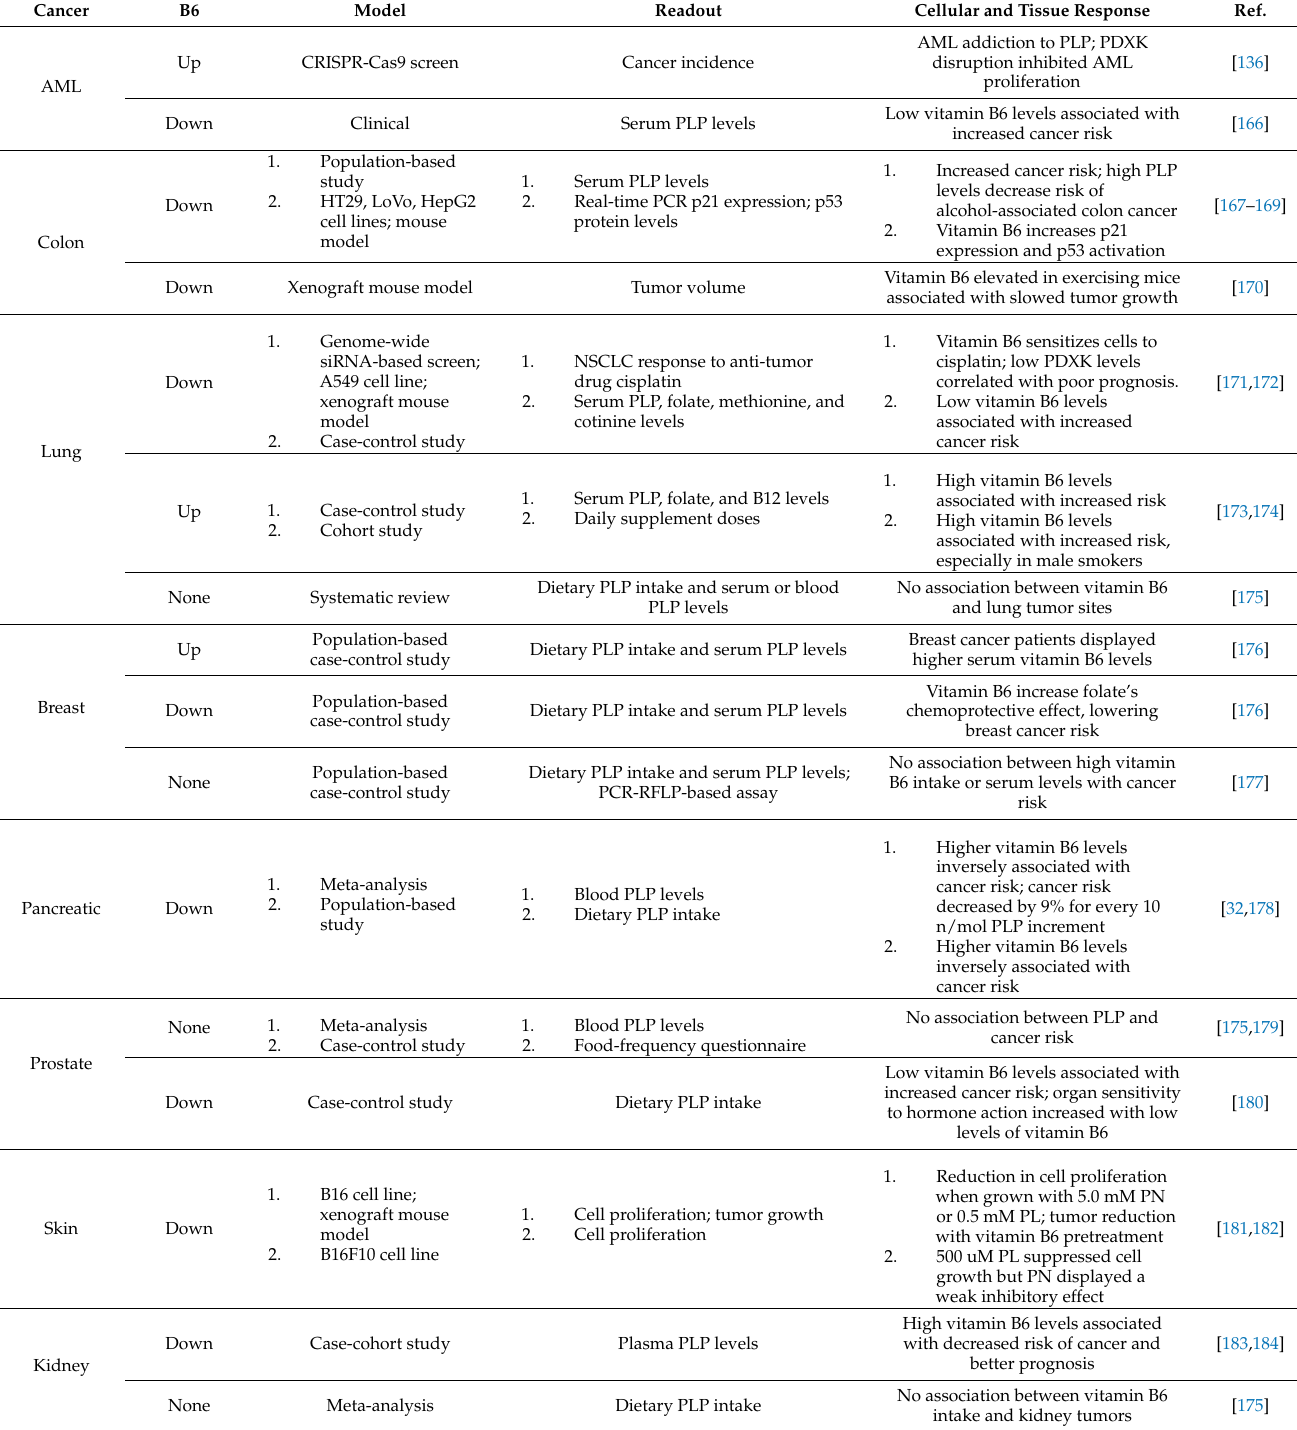
Table 3. Vitamin B6 has been implicated across a range of cancers. Cellular and tissue responses are